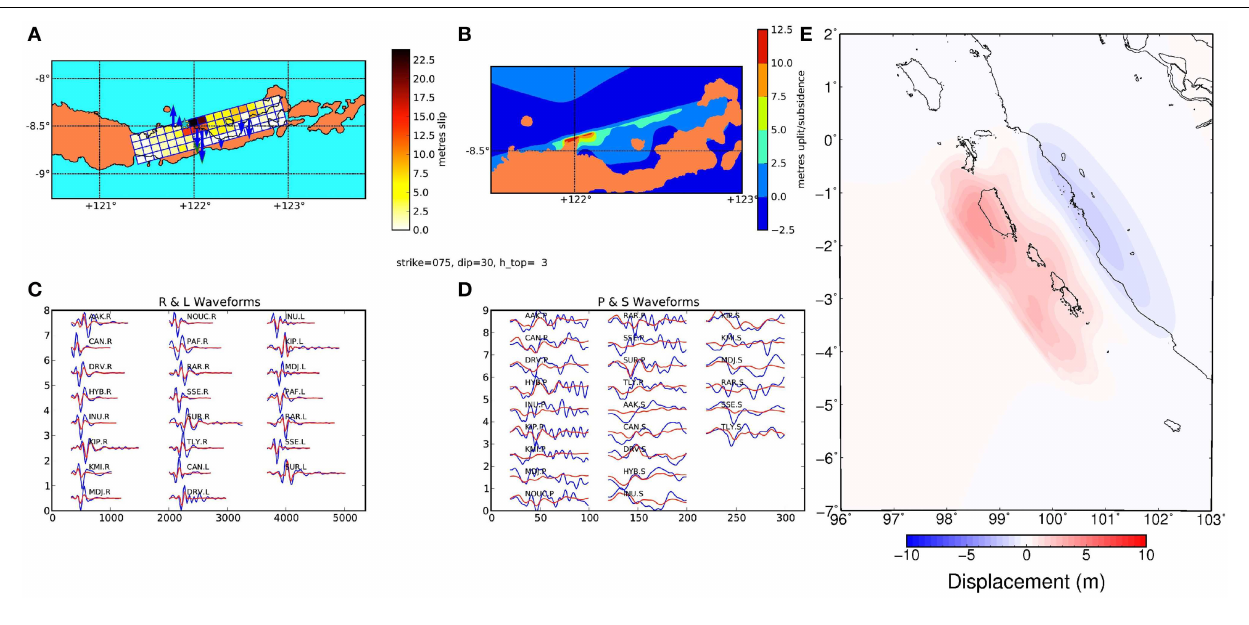
FIGURE 4 | Source model for the 1992 Flores earthquake and tsunami. (A) Best fit model of slip distribution with observed (blue) and modeled (green) subsidence shown by vertical arrows; (B) resulting surface